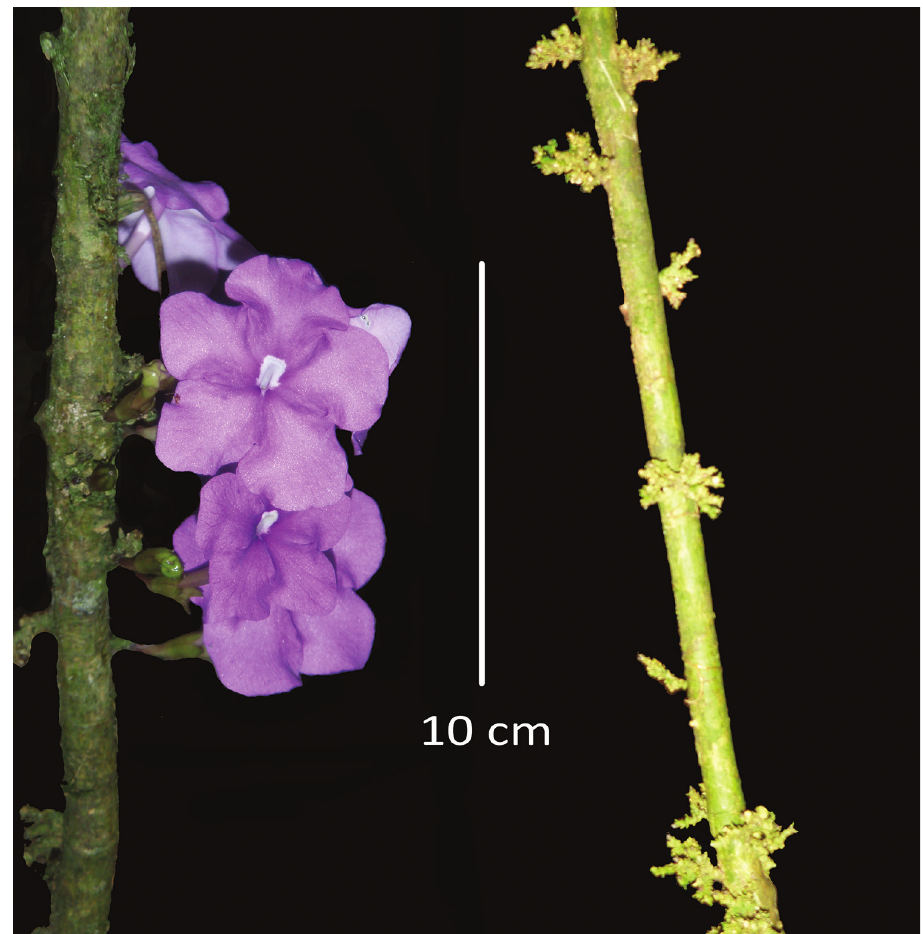
Figure 2. Inflorescences of Brunfelsia cabiesesiana . Left, cauline corymbiform inflorescences showing limb of corolla at anthesis. Right, stem with bracteate inflorescence